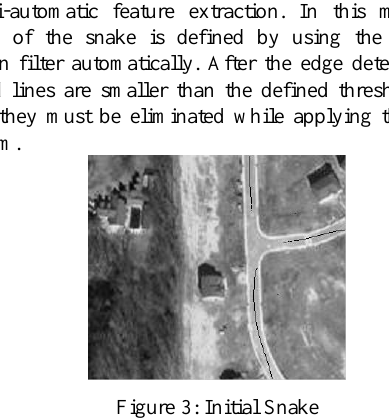
During Ribbon snake application, initial snake position is moved towards ribbon snake’s left and right.